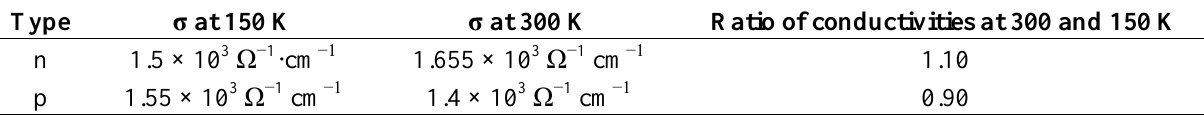
Table 1. Electrical conductivity of n-type and p-type Bi is −170 μV/K for the n-type material and 160 μV/K for the p-type